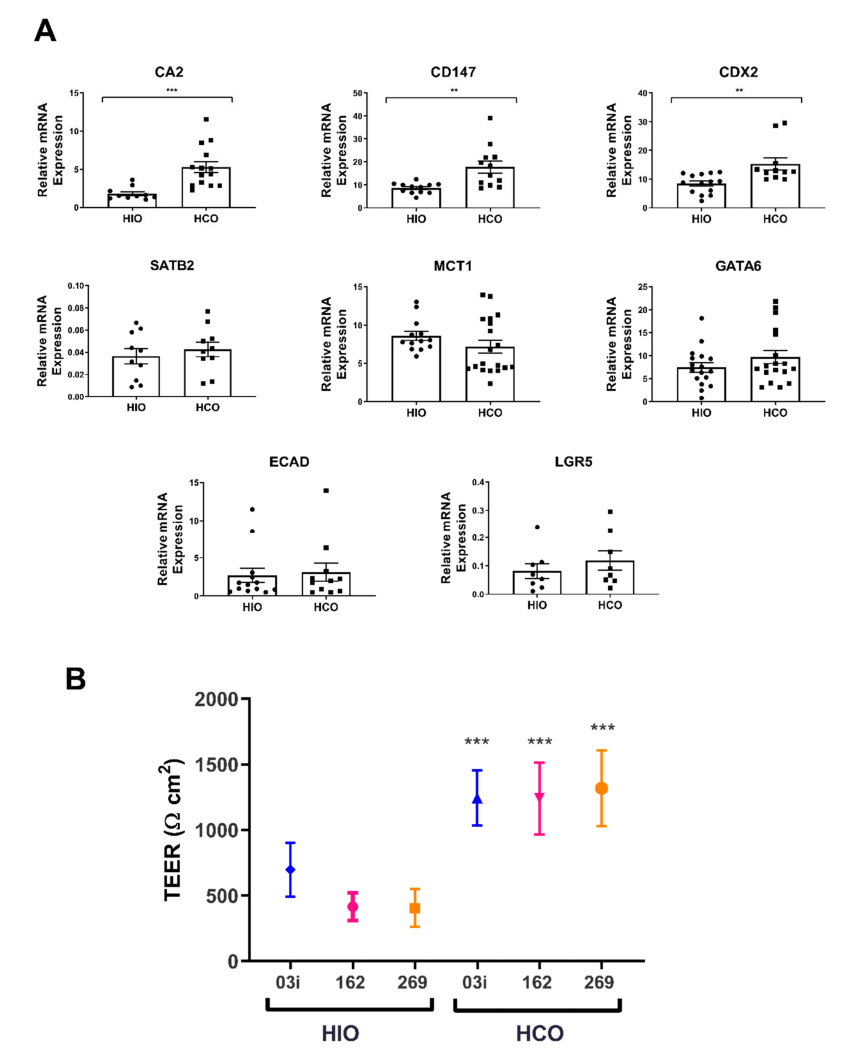
Figure 2. ( A ) qRT-PCR quantification of gene expression for colonic ( CD147 , CDX2 , MCT1 , CA2 ), and genes found throughout intestinal tract ( GATA6, ECAD and LGR5 ). Relative gene expression is shown as percentage of GAPDH. Students unpaired t test, ** p < 0.01, *** p < 0.001, **** p < 0.0001 compared with HIO. Each value represents the mean ± SEM, n = 3 (03i, 162i, 269i), with 3 independent replicates of each cell line. ( B ) Basal transepithelial electrical resistance (TEER) of HIO- and HCO-derived epithelium grown on Transwell inserts for 18 days. Two-way ANOVA with Bonferroni’s multiple comparisons; * p < 0.05, ** p < 0.01, *** p < 0.001 compared with respective control. Each value represents the mean ± SD, n = 3, with 6 independent